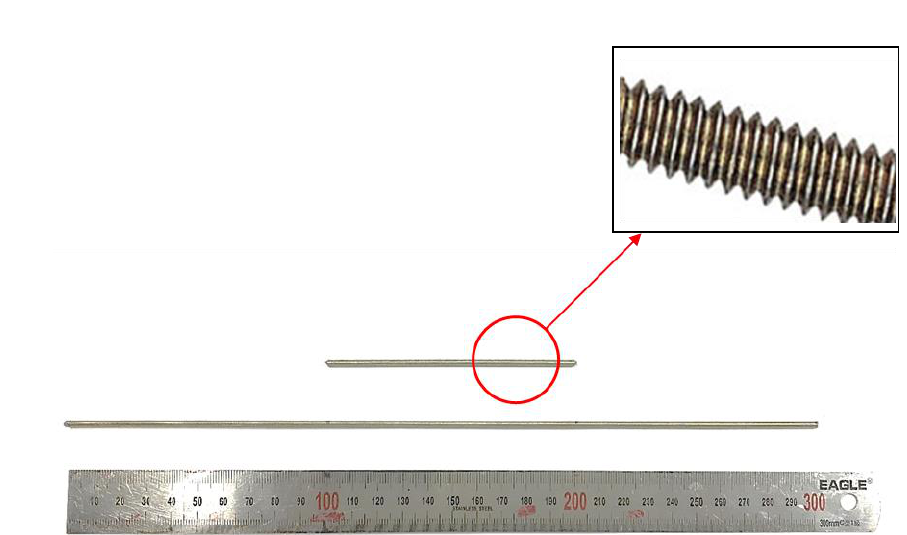
Figure 1. Interlayer reinforcements.